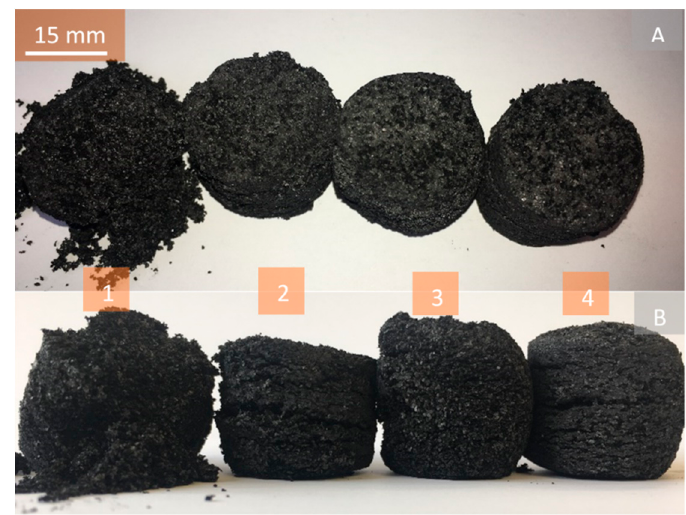
Figure 10. SBH/G+C (1:1) pellets, after 10 complete cyclic tests, as No.1, No.2, No.3, No.4 pellets with the compression pressures of 1.3, 2.6, 3.9, 5.2 kN ⋅ mm − 2 , respectively. ( A ) shows the top view, and ( B ) shows the side view of the pellets.